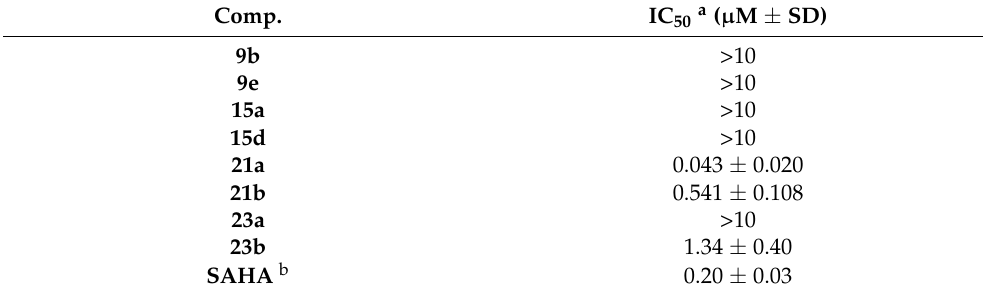
Table 2. In vitro anti-proliferative activities of representative compounds against MM.1S cell line.